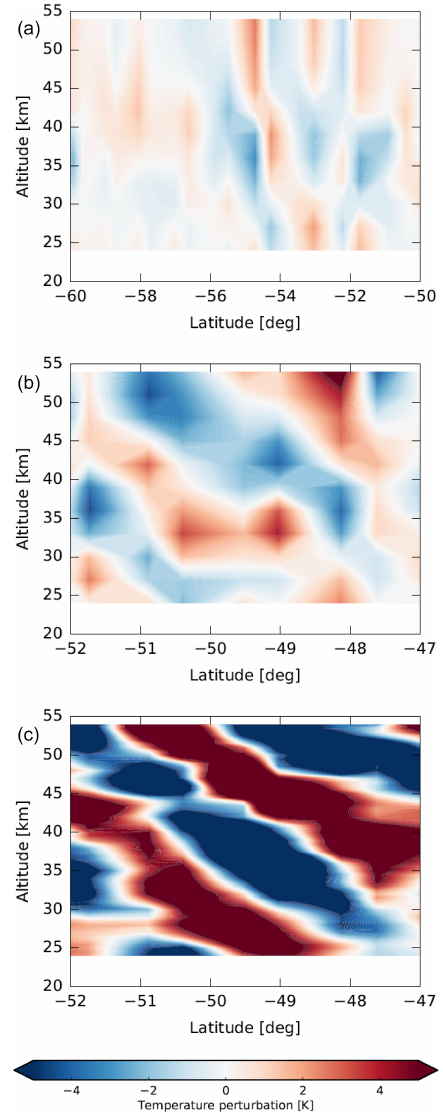
Figure 7. Same as Fig. 5 but for a non-orographic gravity wave event over the southern Indian Ocean on 8 August 2007 at about